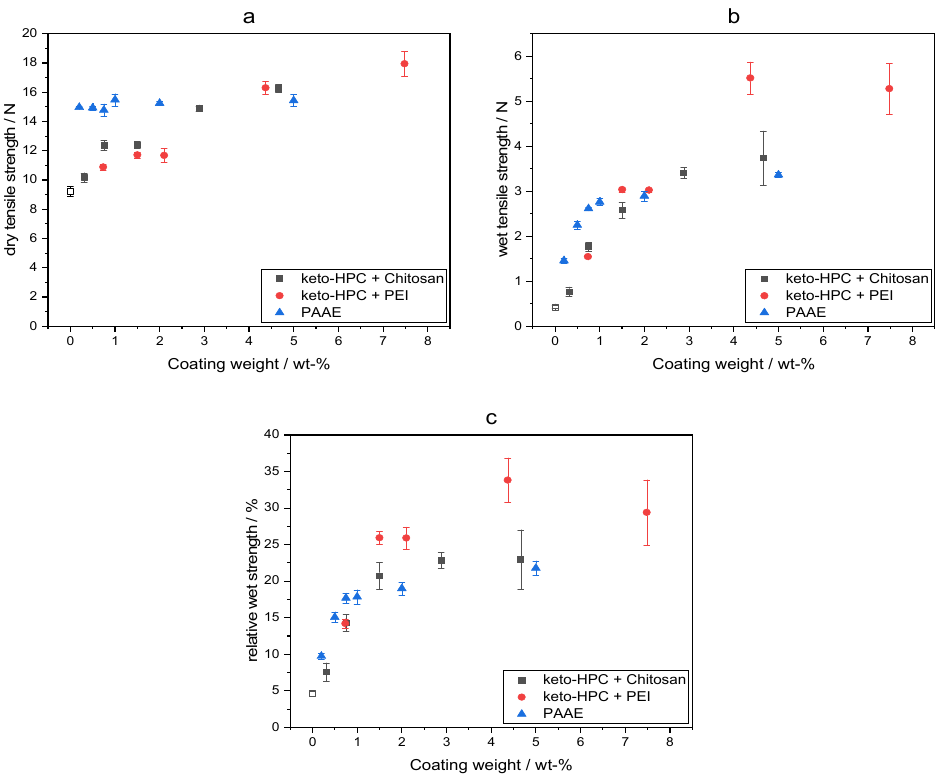
Figure 6. Influence of the coating weight of keto-HPC in combination with chitosan (black), PEI (red) and PAAE (blue), respectively, based on dry cotton linter fibers on dry tensile strength ( a ), wet tensile strength ( b ) and relative wet strength ( c ).